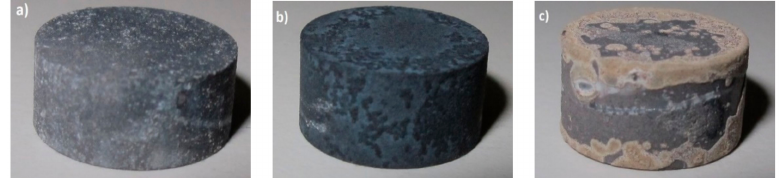
Figure 1. Photographs of the coatings obtained on Ti-15Mo in the electrolytes of series 1, 3, 4 ( a ); 2, 5 ( b ), and 6–8 ( c